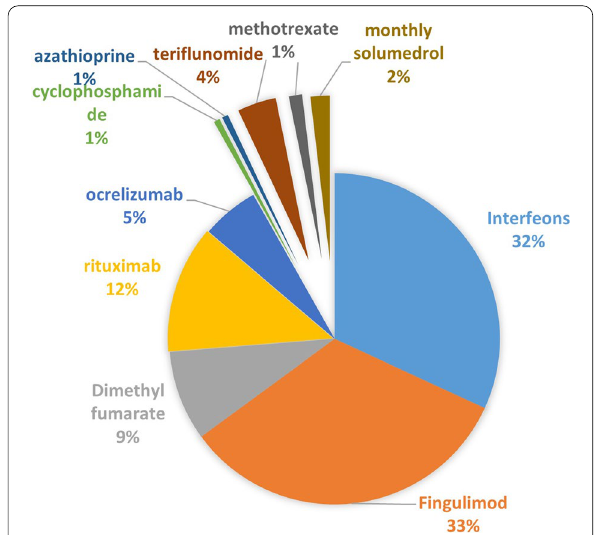
Fig. 1 Patients’ current DMDs